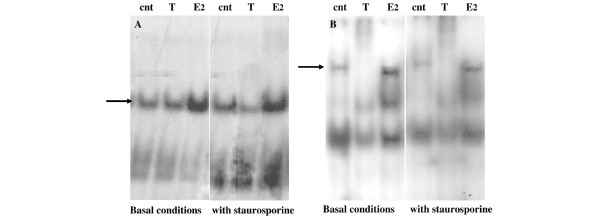
Electrophoretic mobility shift assay for NF-κB (arrow) in the cultured human THP-1 cell line. (a) Electrophoretic mobility shift assay for NF-κB (arrow) in the cultured human THP-1 cell line after 168 hours of hormonal treatment and without or with staurosporine (17 nM) reveals an increased DNA binding in 17β-oestradiol (E2)-treated cells. (b) Super shift assay for p65 (arrow) in the cells under the same conditions confirms the increased binding of p65 in E2-treated cells. The results are representative of four separate experiments. cnt, control; T, testosterone.